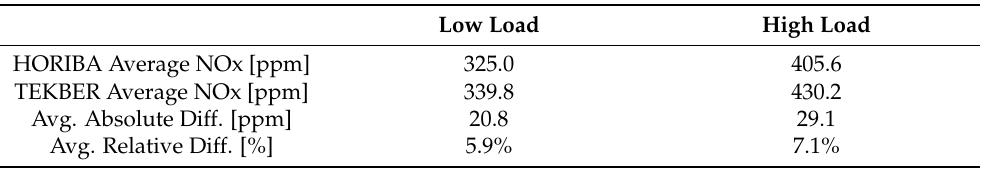
Table 3. Summary of the average concentrations and differences for the Static Idling Internal Load Test without EGR.